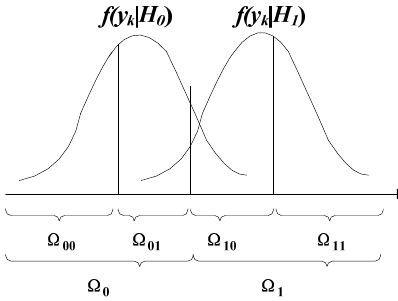
Figure 5. The subpartitioning figure in the 2-bit decision case.